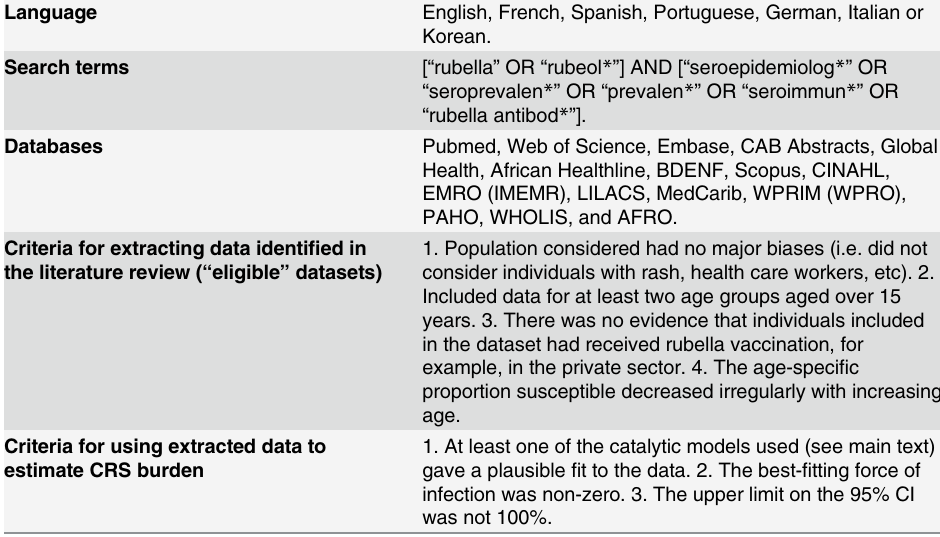
Table 1. Literature search strategy and inclusion criteria for